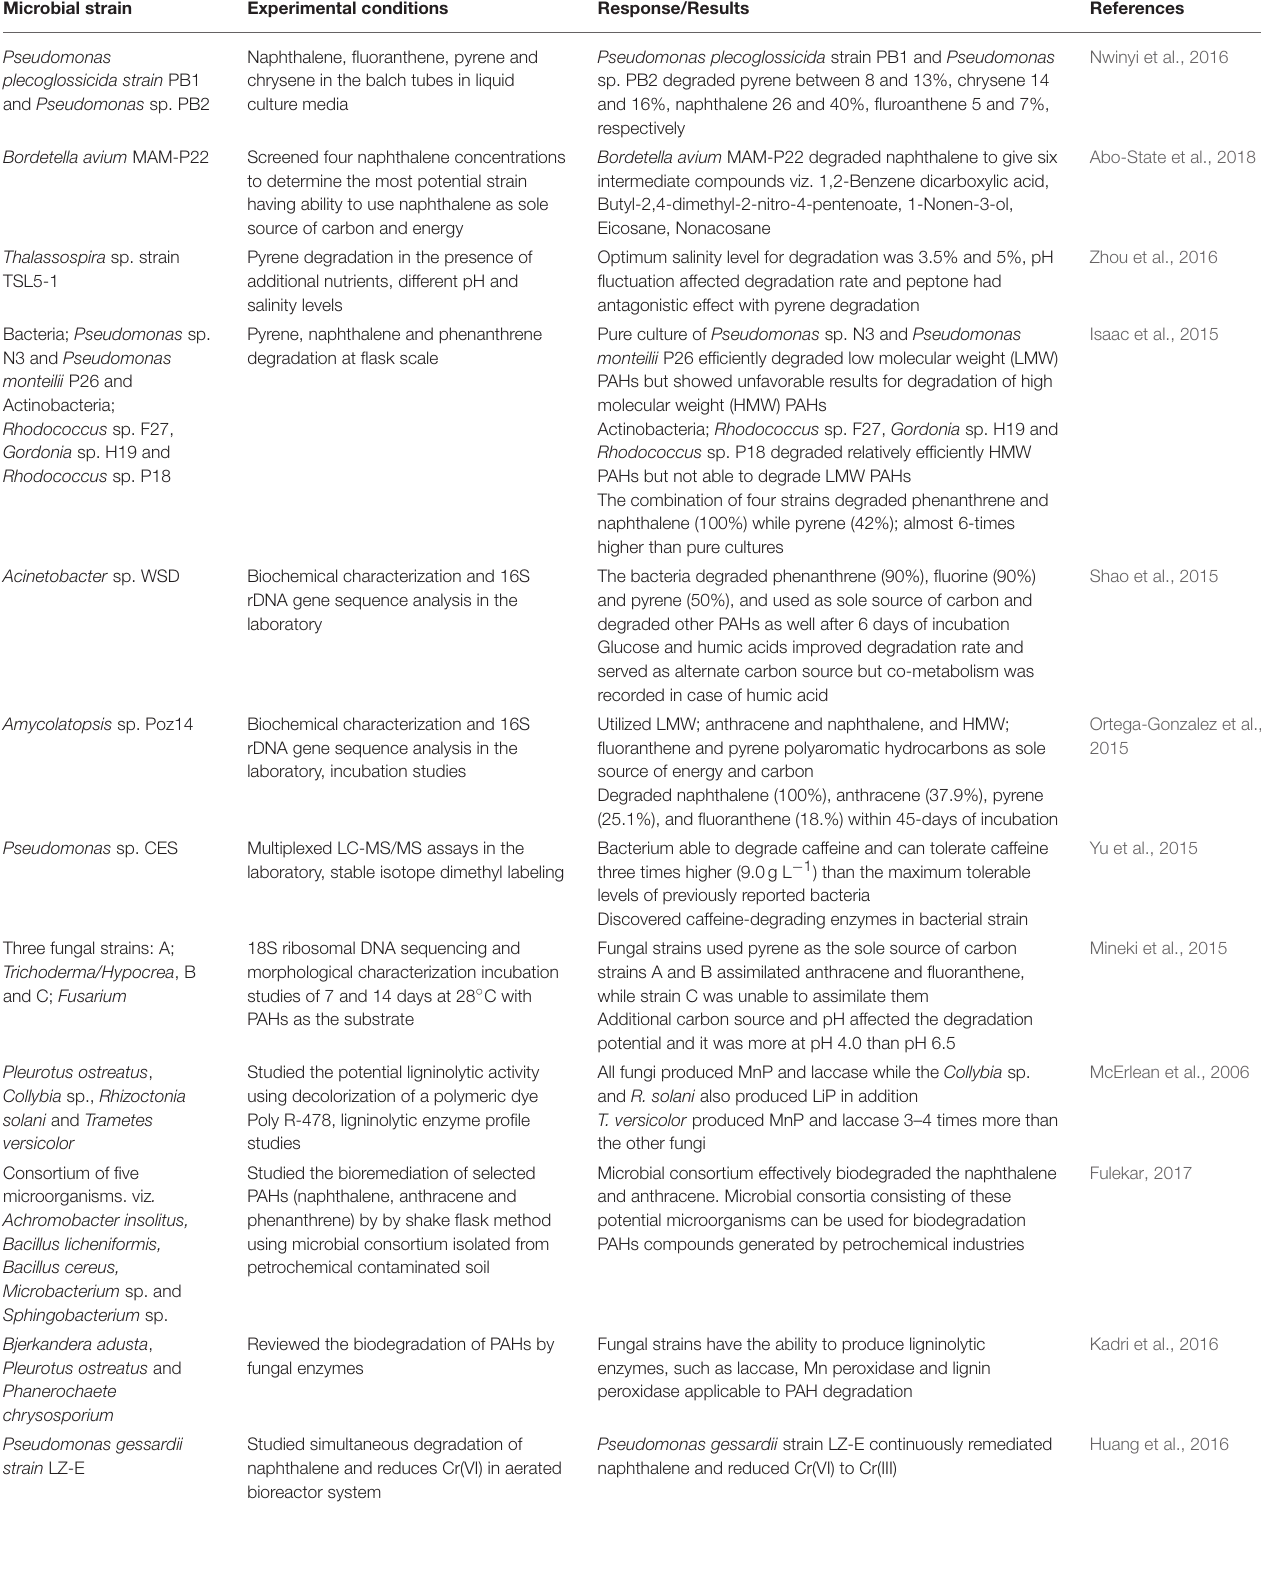
TABLE 3 | Microbial strains tested for degradation of polyaromatic